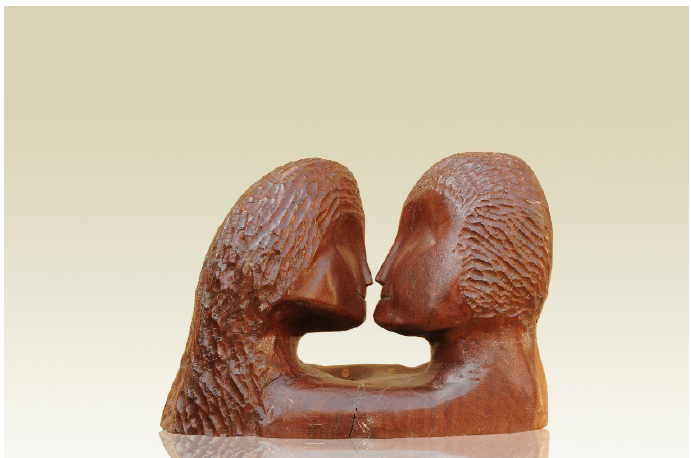
Figure 1. Haim Azuz. A Presence of Two (2010). Eucalyptus wood, 40×20×30 cm (source: courtesy of the